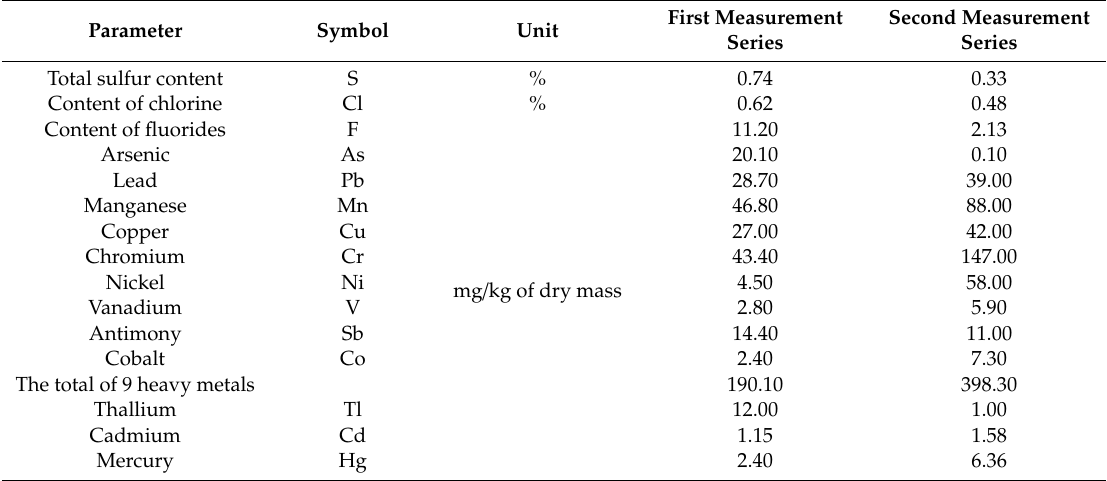
Table 2. Content of the selected elemental composition items for waste mixtures under analysis. Parameter Symbol